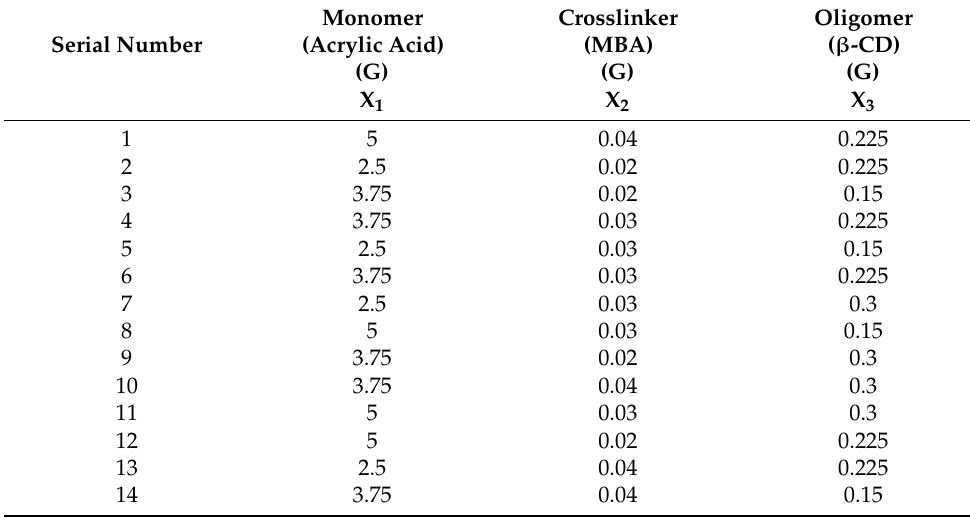
Table 1. Ratio of excipients used in the preparation of β -CD hydrogels by Design